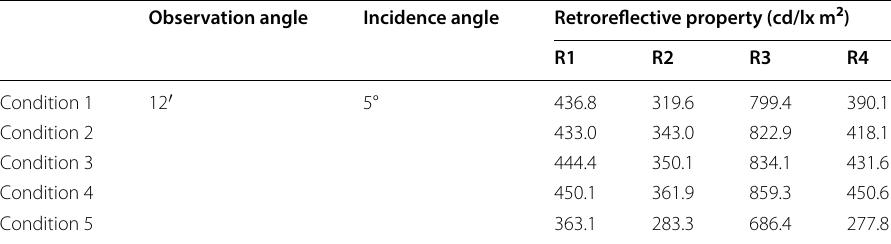
Table 6 Retroreflective properties at 12 ′ (0.2°) observation angle and 5° incidence angle after 5